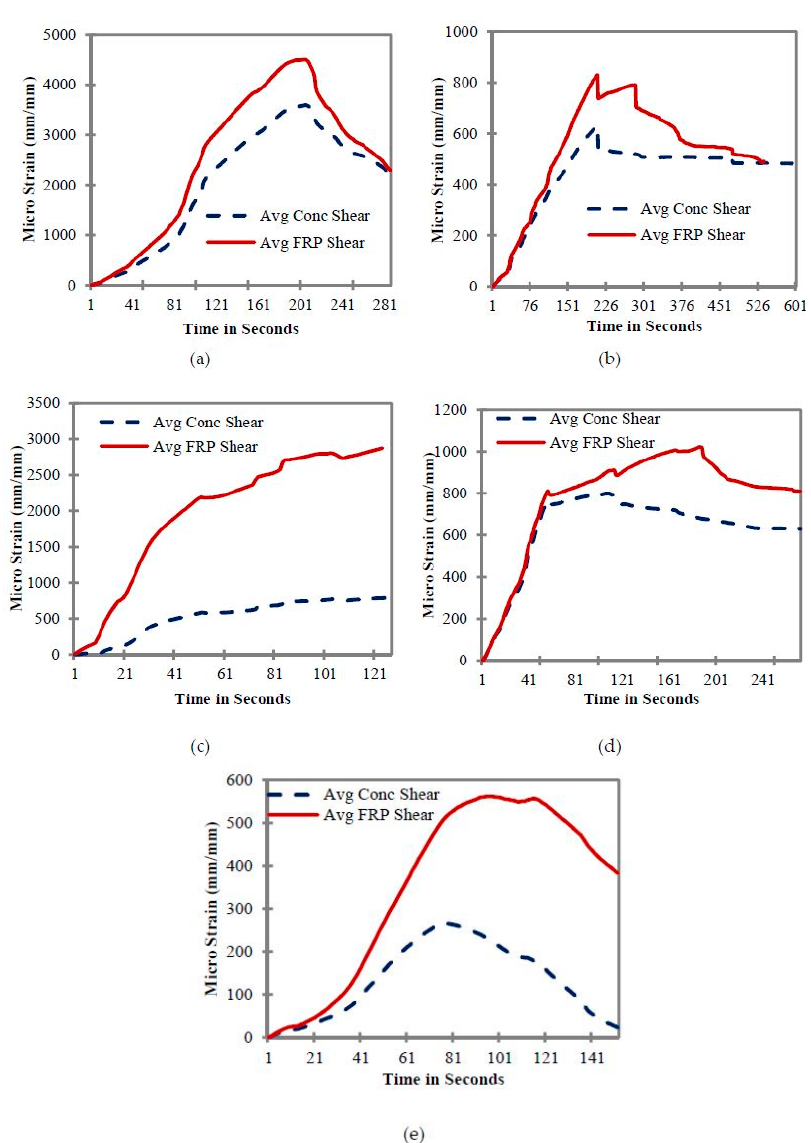
Figure 10. Comparison of concrete and CFRP shear strain for ( a ) B2, ( b ) B3, ( c ) B4, ( d ) B5, and ( e ) B6.